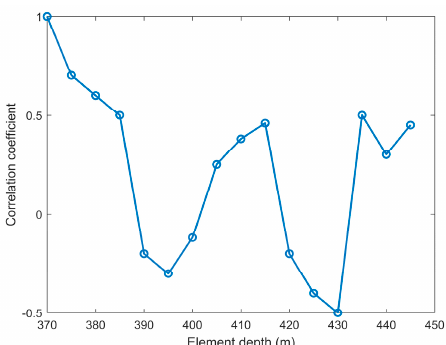
Figure 19. Correlation coefficients of signal.